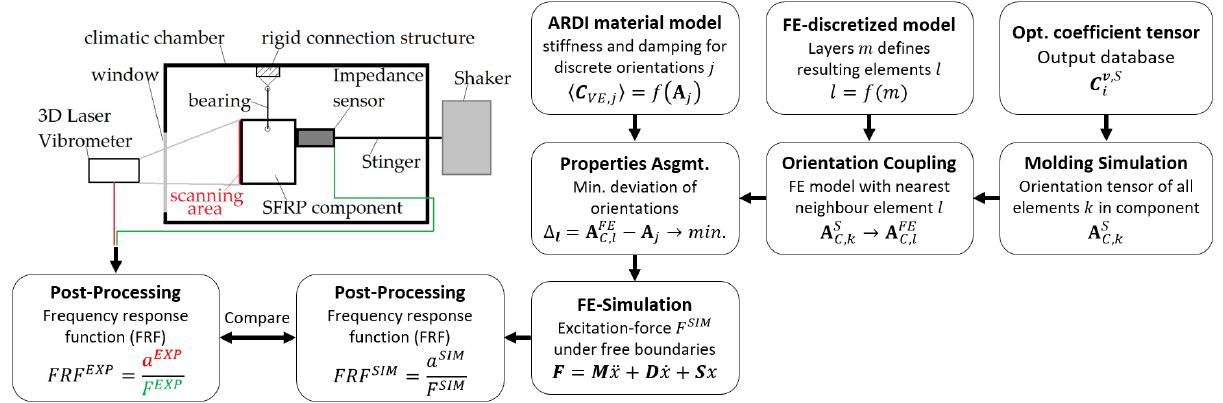
Figure 4. Method for the experimental and simulative characterization of the structural dynamics of short-fiber reinforced thermoplastic